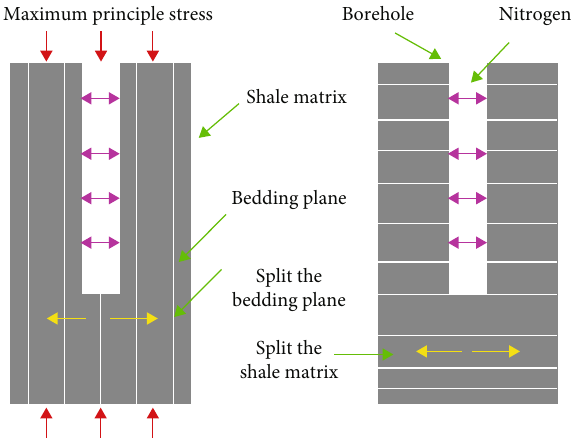
Figure 16: Diagram of shale in the nitrogen fracturing